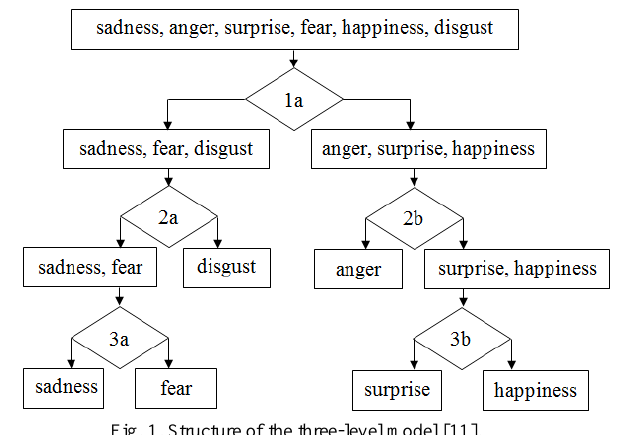
Fig. 1. Structure of the three-level model